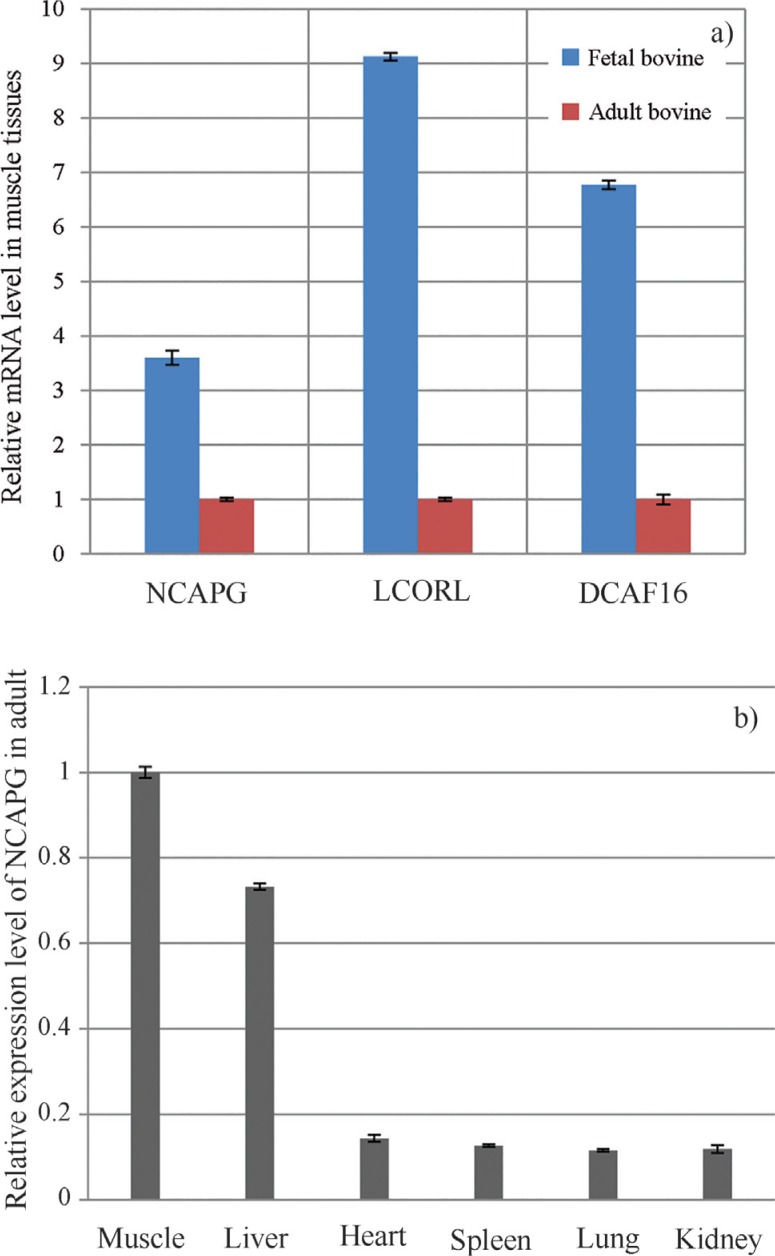
A. Expression levels of the NCAPG, LCORL
and DCAF16 genes in fetal and adult muscle tissue, B.
Tissue-specific expression patterns of the NCAPG gene in adult
cattle. The columns represent the means ± SEM (n = 3).